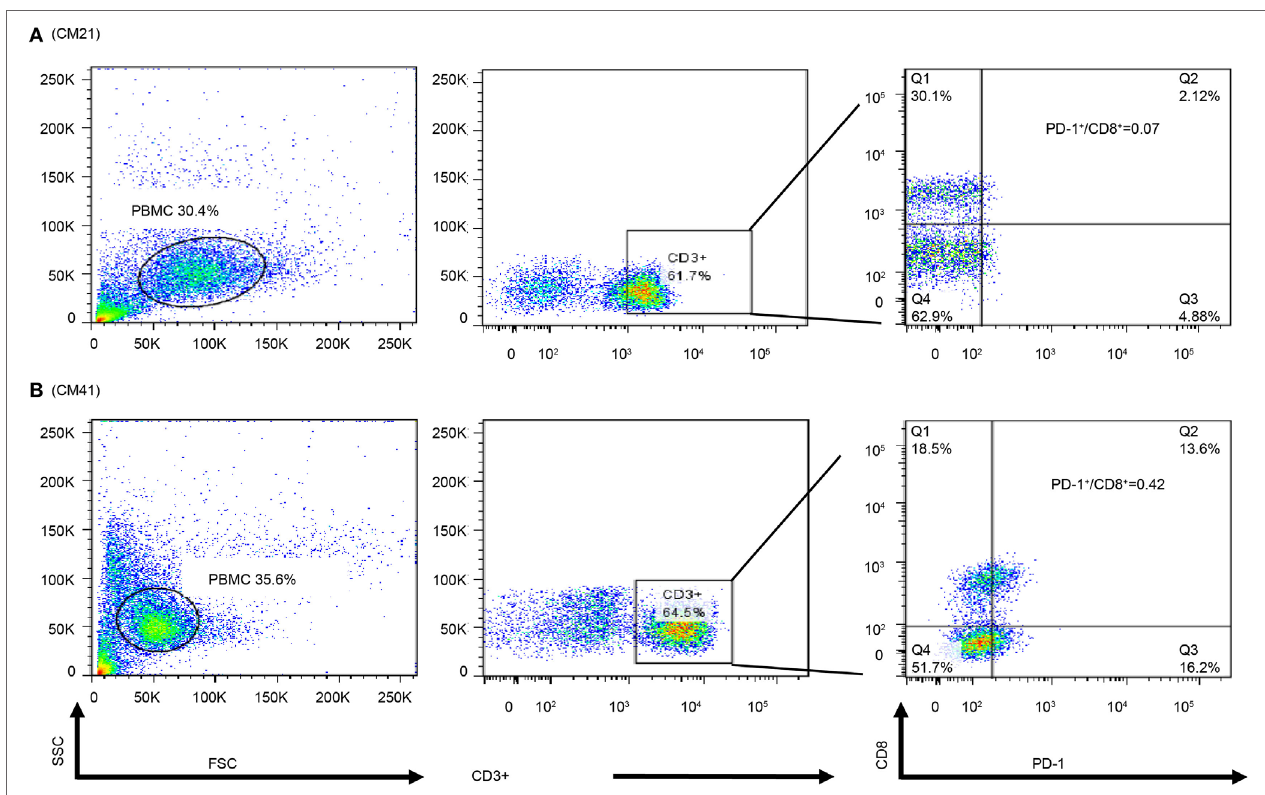
FigUre 10 | Flow cytometry of peripheral blood mononuclear cells (PBMCs) of representative patients. PBMCs (1 × 10 5 ) were collected and stained with antibodies against programed death 1 (PD-1), CD8, and CD3. The percpCy5.5-labeled CD3 + T cells (middle panel) were gated form the size and granularity dot-plot (left panel), then these CD3 + T cells were analyzed by the PE-Cy7 and FITC dot-plot to identify the populations of CD8 and PD-1-expressing cells. Patient 21 had a low PD-1 + / CD8 + ratio in the PBMC cytoblock (a) . Patient 41 was with a high PD-1 + /CD8 + ratio in PBMC cytoblock (B)